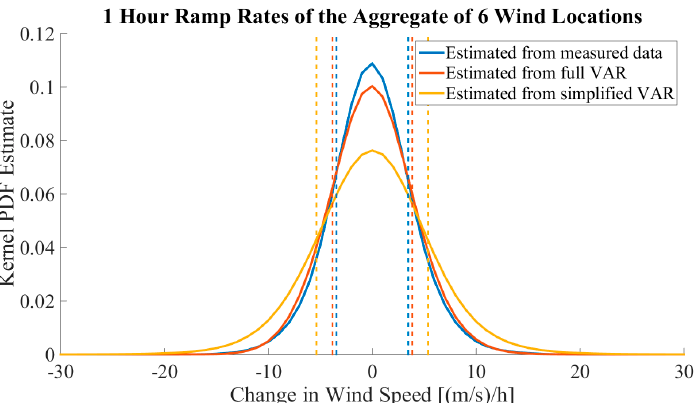
Figure 5. The one-hour ramp rate PDFs estimated from the aggregated measurement data and from the aggregated simulated data from the two models for the six wind speed test locations. The dotted lines with corresponding colors illustrate the standard deviations of the one-hour ramp rates in the three cases. The presented simulation results are averages of the 100 MC runs.